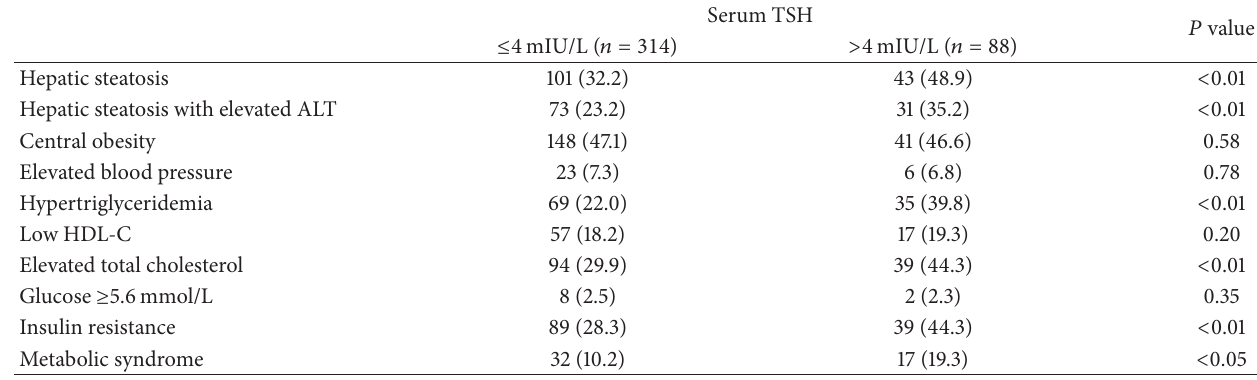
Table 2: Prevalence of hepatic steatosis, hepatic steatosis with elevated ALT, metabolic syndrome, and its components according to serum TSH among 402 overweight/obese children.